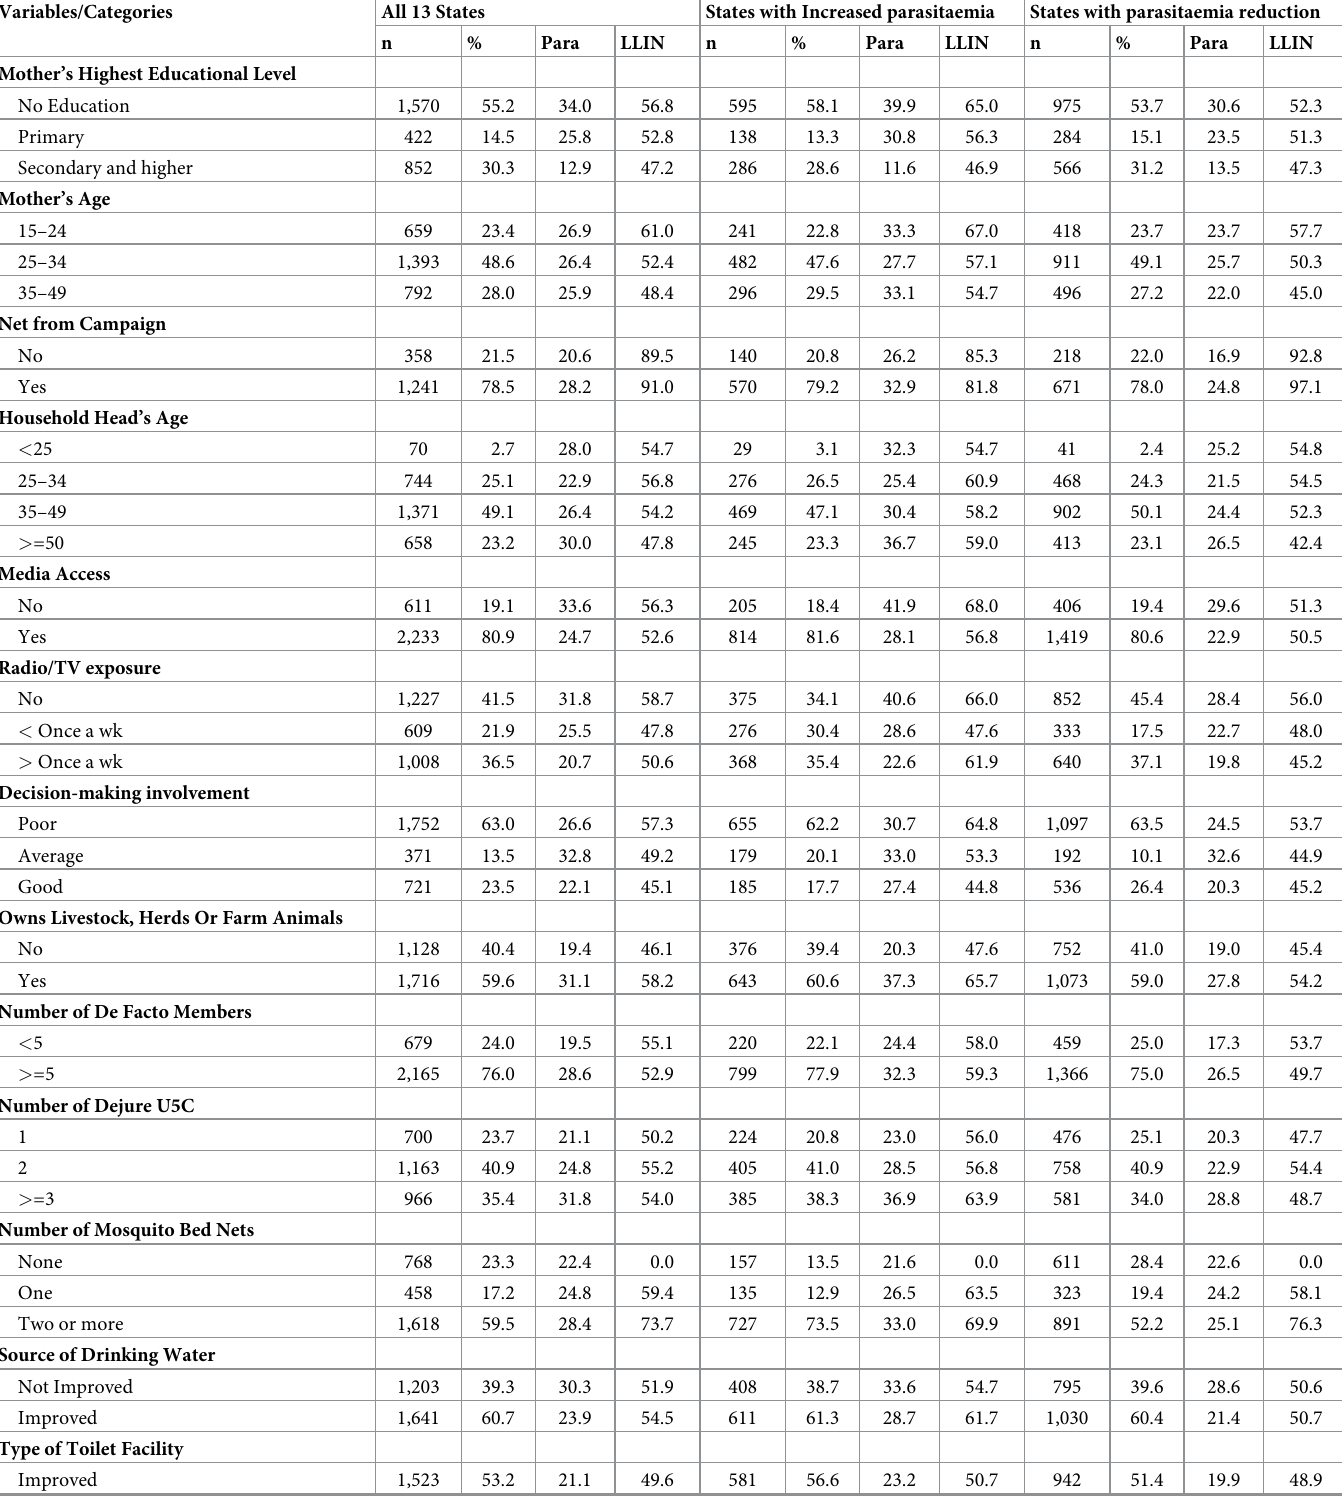
Table 3. Distribution of the mothers’, household, and community characteristics in the study States, NDHS 2018. Variables/Categories